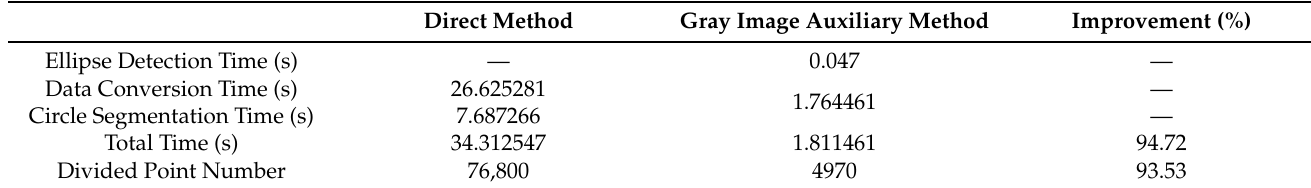
Table 1. Comparison of point cloud segmentation algorithm